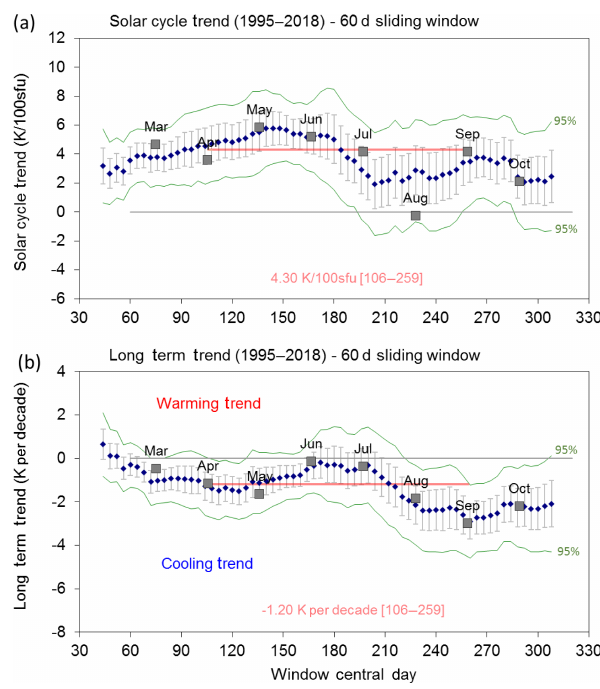
Figure 5. The seasonal variability in (a) solar cycle and (b) long- term trend coefficients derived using a 60d sliding window (blue dots) and as monthly trends (grey boxes) compared to the winter mean trends (red lines) derived for Fig. 3. The green lines show the confidence limits (95%) for the trend